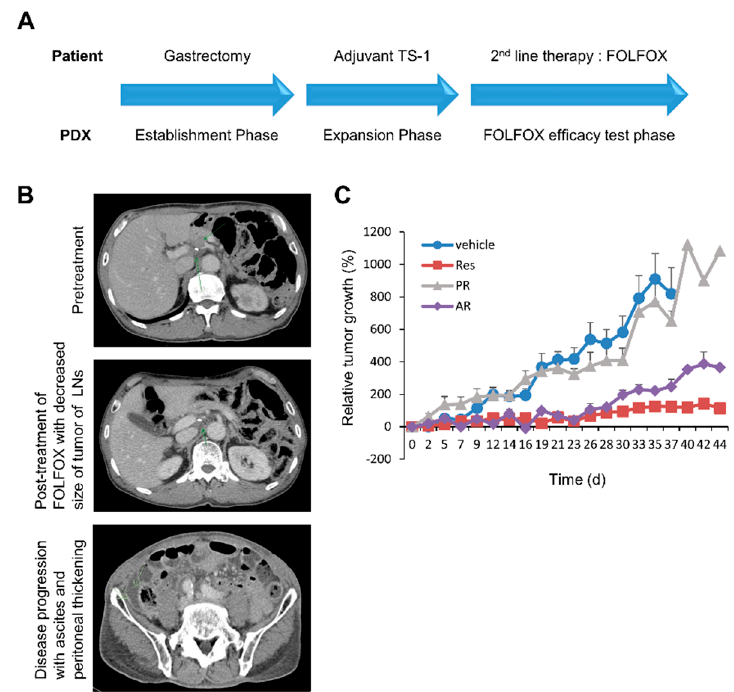
Figure 2. The poor clinical outcome of GC patient, and the heterogeneous response of patient-derived xenograft (PDX) tumors to 5-fluorouracil and oxaliplatin modulated with leucovorin (FOLFOX) . ( A ) Establishment and treatment of PDX tumors simultaneously with the clinical course of the patient. After gastrectomy, the primary tumor of the patient was engrafted into nude mice and allowed to expand for a FOLFOX-efficacy test. The patient in whom the adjuvant TS-1 chemotherapy has failed was administered into second-line therapy with FOLFOX accompanied by PDX. ( B ) CT images taken during the clinical course of the patient. The recurrent tumors (upper panel, arrow) showed a reduction in size after FOLFOX chemotherapy (middle panel, arrow). Subsequently, the peritoneal metastasis (lower panel, left arrow) grew, and ascites (lower panel, right arrow) developed. Tumor-bearing immunodeficient mice ( n = 8 vehicle and n = 9 FOLFOX mice in each treatment group) were treated when the tumor had reached a volume of 100–200 mm 3 . FOLFOX (5-fluorouracil at 15 mg/kg and oxaliplatin at 5 mg/kg) was administered as described in the Methods section. ( C ) The reanalyzed tumor growth kinetics ( n = 9 vehicle, n = 3 Res, n = 3 PR and n = 2 AR) from the FOLFOX-treatment experiment (Figure S3a).